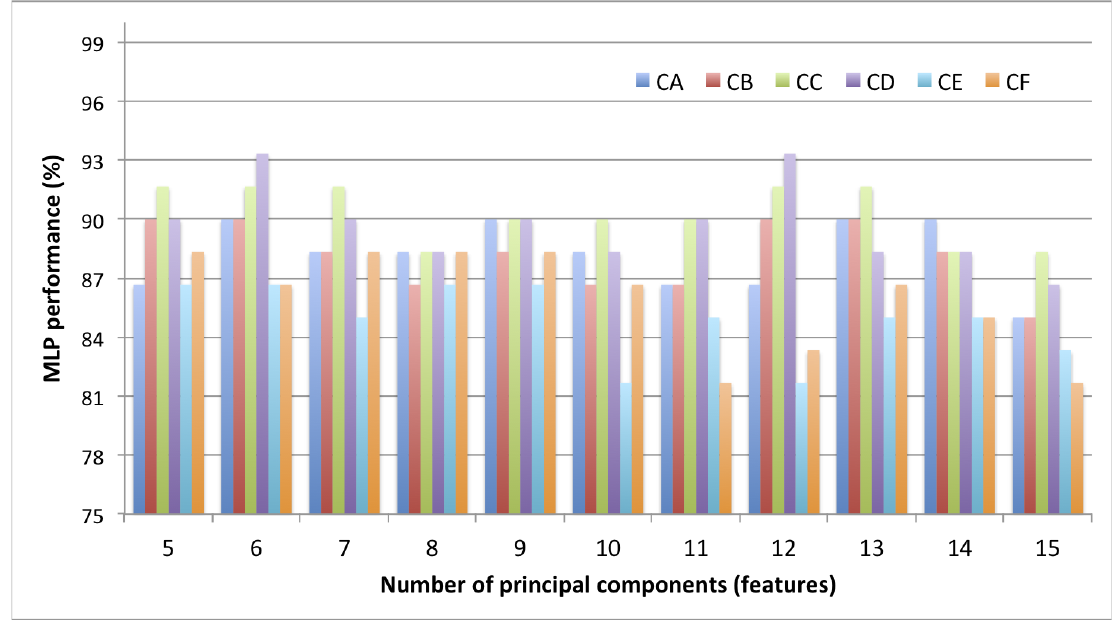
Figure 7. MLP performance based on number of features (5–15